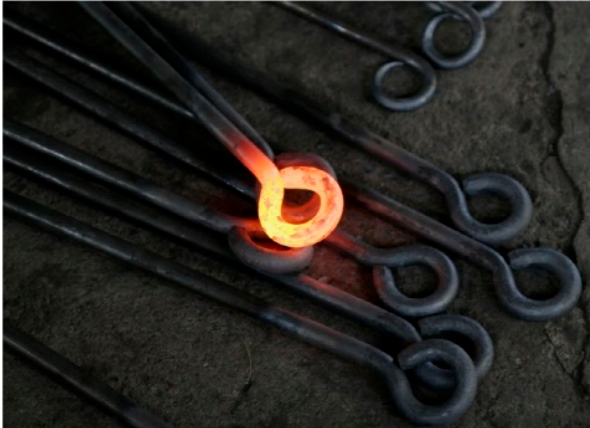
Figure 4. Hot iron objects, transferring heat to the surrounding environment.